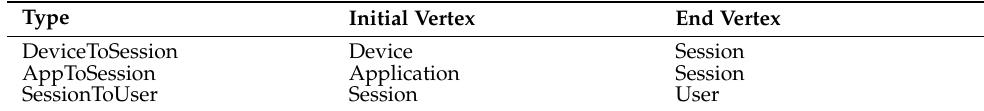
Table 5. Types of links between